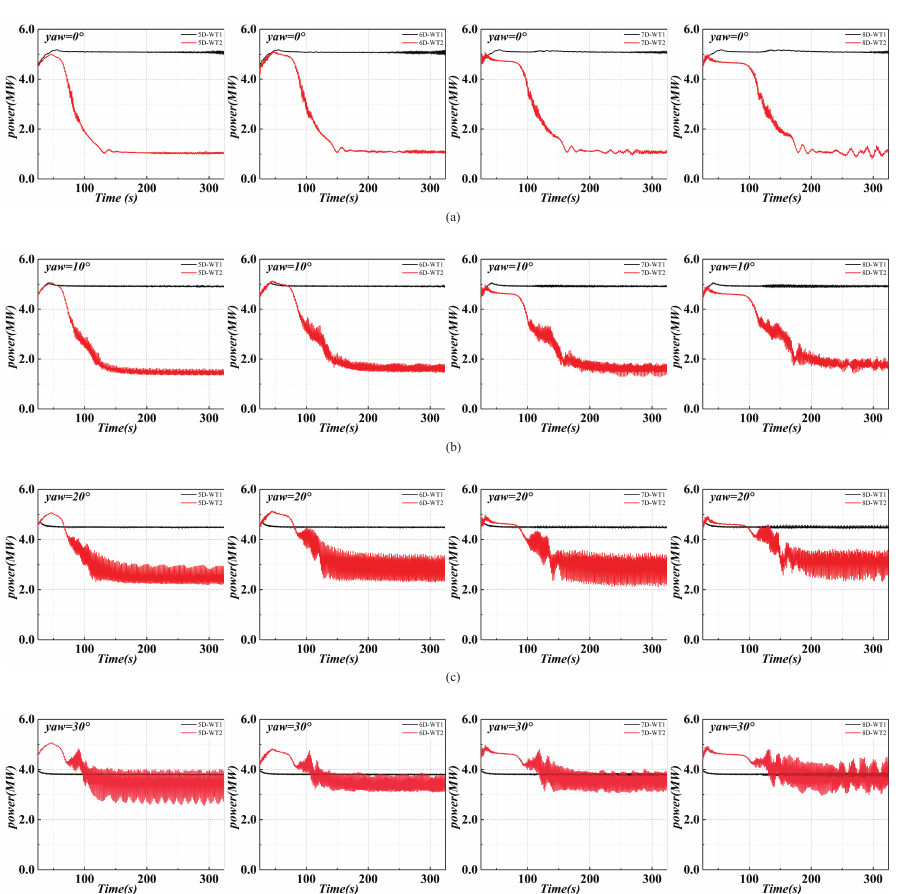
Figure 7. Power-time curves of two turbines with different spacings and upstream yaw angles: ( a ) yaw = 0 ◦ ; ( b ) yaw = 10 ◦ ; ( c ) yaw = 20 ◦ ; ( d ) yaw = 30 ◦